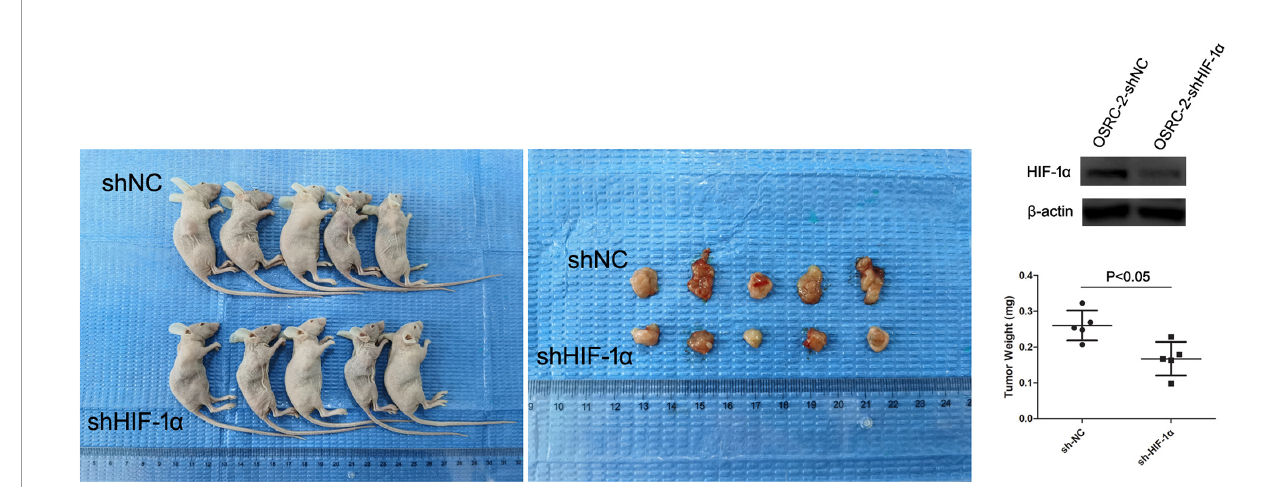
FIGURE 4 | Nude mouse experiment. The expression of HIF-1 a was signi fi cantly downregulated in OSRC-2 cells transfected with HIF-1 a -shRNA compared to NC- shRNA-transfected cells (P <0.01). The representative graphs show that tumors formed. Knockdown of HIF-1 a suppressed tumor volumes (P = 0.0159).